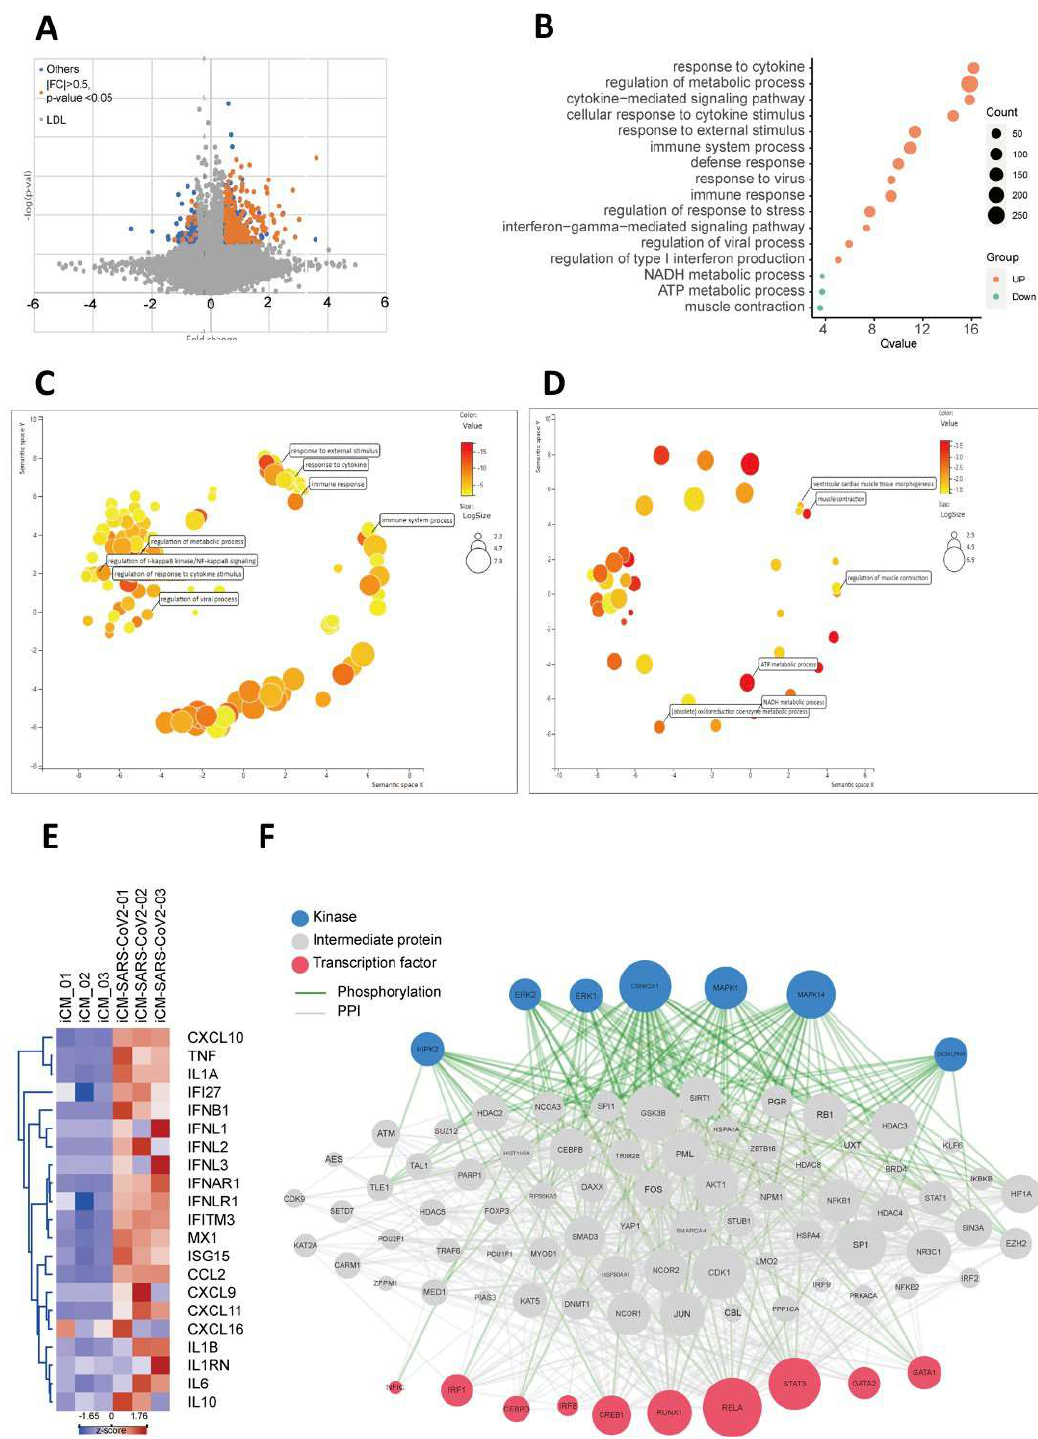
Figure 4. RNA-seq analysis of hiPSC-derived iCMs after SARS-CoV-2 infection. ( A ) Volcano plot showing the genes that were either upregulated or downregulated by SARS-CoV2 infection. ( B ) Enrichment plot showing several pathways that were either enriched or suppressed by SARS-CoV2 infection. Those enriched pathways were related to the regulation of the metabolic pathways, response to cytokine, cytokine-mediated signaling pathway, cellular response to cytokine stimu- lus, response to external stimulus, immune system process, response to the virus, regulation of response to stress, inter- feron-gamma-mediated signaling pathway, regulation of the viral process, regulation of type I interferon production.